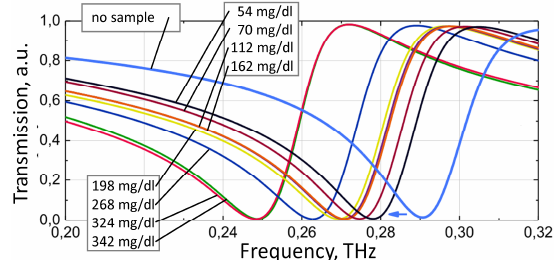
Fig. 4. With increasing of blood glucose concentration, we observe resonance frequency shift, which value directly correlates with blood glucose concentration.